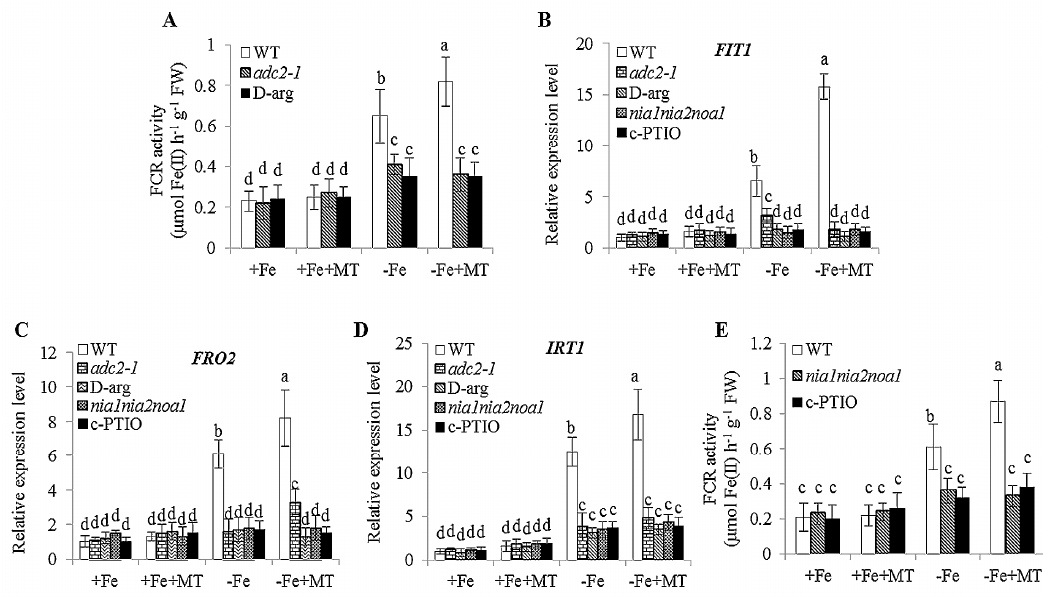
Figure 10. The effect of exogenous melatonin on the FCR activities and the expression of Fe-acquisition-related genes in polyamine- ( adc2-1 and D -arg-treated) and NO-deficient ( nia1nia2noa1 and c-PTIO-treated) Arabidopsis plants. Seven-day-old seedlings were treated with or without 5 µ M melatonin in the presence or absence of 50 µ M Fe for 8 days. Roots from adc2-1 and D -arg-treated plants were sampled for measuring the FCR activities ( A ). The expression levels of Fe acquisition-related genes, including FIT1 ( B ), FRO2 ( C ), and IRT1 ( D ), were examined after seven-day-old seedlings were placed in the − Fe or +Fe medium with or without the presence of 5 µ M melatonin ( − MT or +MT) for 8 days. In addition, roots from nia1nia2noa1 and c-PTIO-treated plants were used to determine the FCR activities ( E ). Each bar is the mean ± SE of at least three replicates, and different lowercase letters above the bars indicate significant differences using Tukey’s test at p < 0.05.